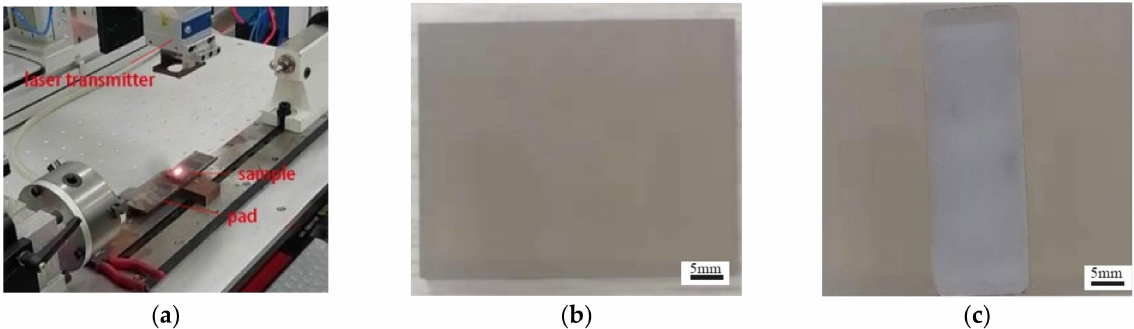
Figure 1. Laser hardening process. ( a ) Laser hardening, ( b ) untreated sample, and ( c ) a sample after laser